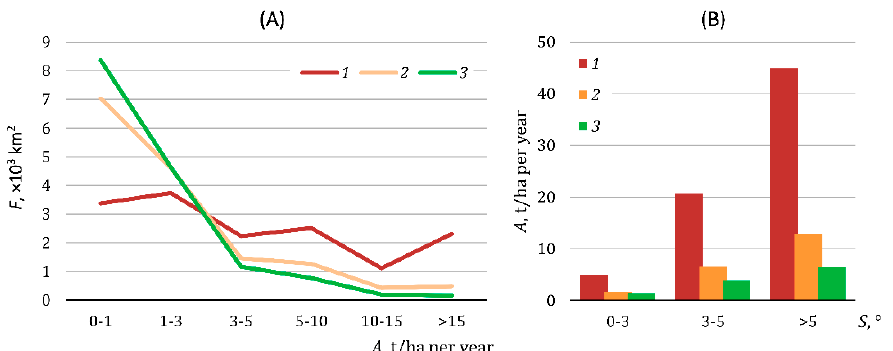
Figure 5. Changes in modeled average annual soil losses ( A ) due to storm-induced erosion in Belgorod Oblast, according to different land-use models: ( A ) soil losses versus area ( F ); ( B ) average annual soil losses versus slope ( S ). 1 —for bare (clean) fallow conditions, 2 —for actual crop composition, 3 —for ALAS projects.